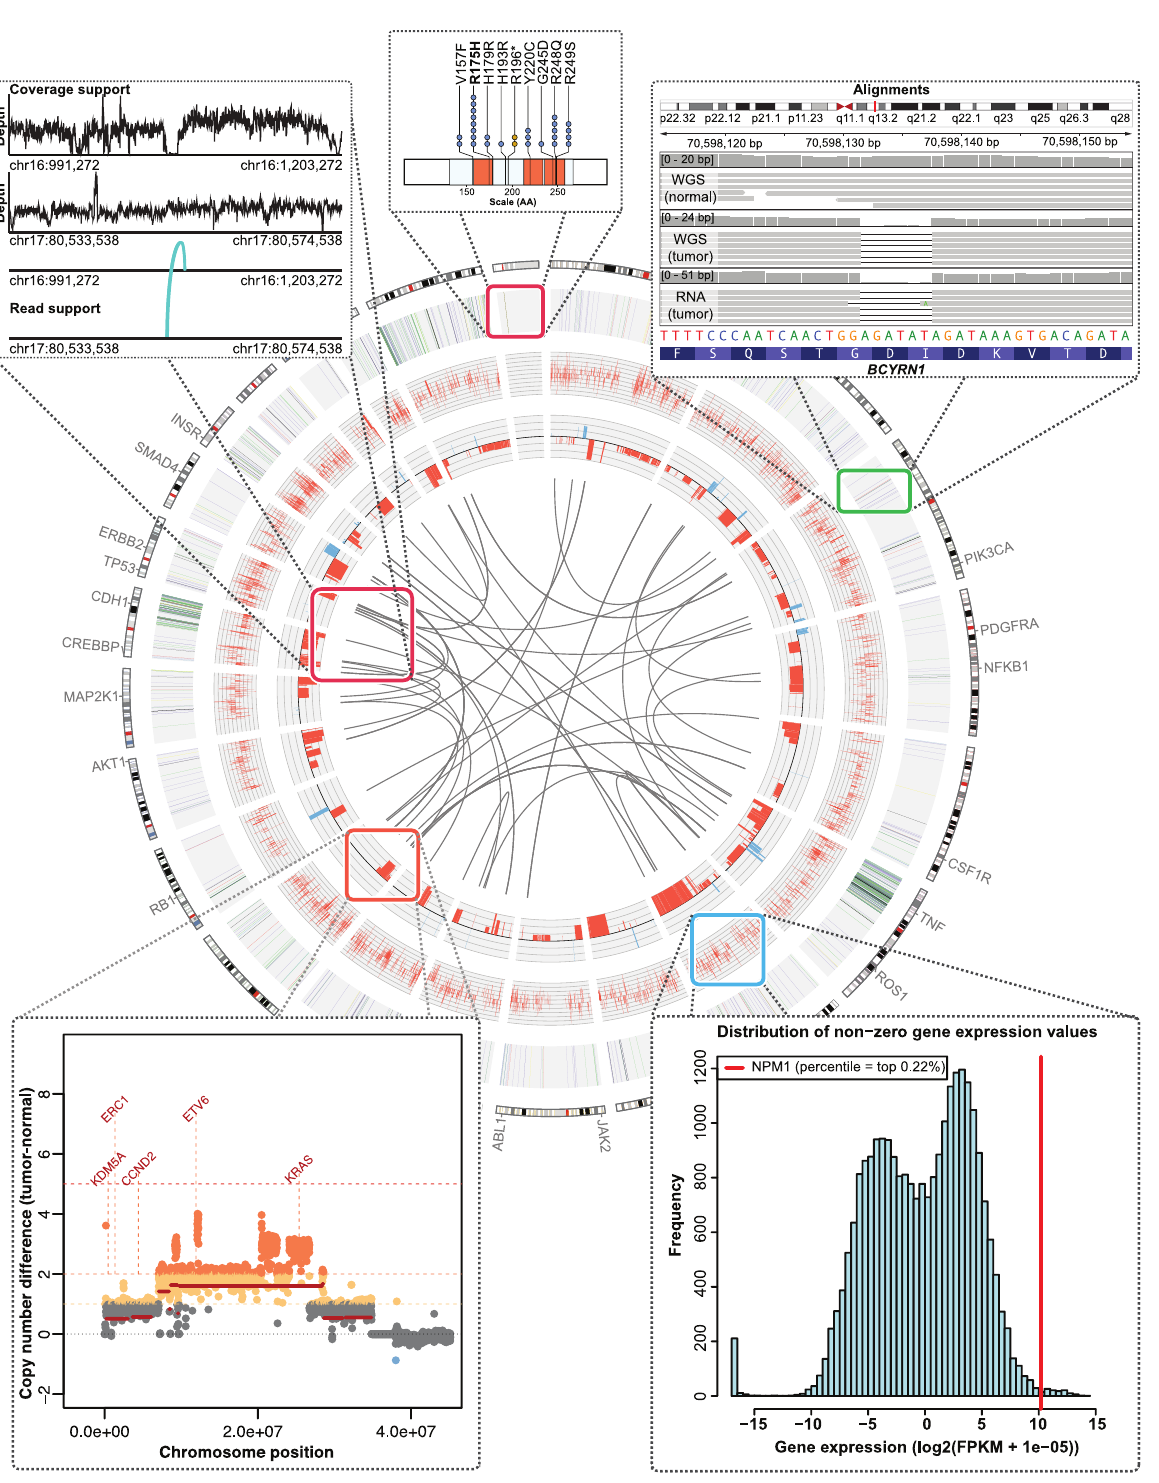
Fig 5. Circos plot of HCC1395 tumor/normal comparison. Circos is a popular tool for summarizing genomic events in a tumor genome. This is just one of many automatically generated visualizations made possible by the GMS. In this example, the WGS, exome and RNA-seq data for HCC1395 are displayed in several tracks along with additional visualizations illustrating individual events. Moving inwards, SNVs and Indels are plotted on the outermost track, then highly expressed genes, CNVs, and finally chromosomal translocations at the center. For events predicted to affect protein coding genes, additional plots are auto-generated to display the mutation position relative to protein domains and previously reported mutations from the Cosmic database, as illustrated in the